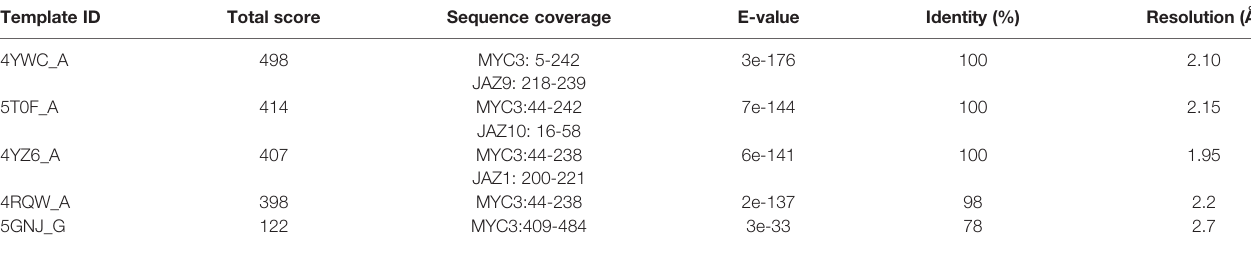
TABLE 1 | Blastp results for MYC3 protein sequence